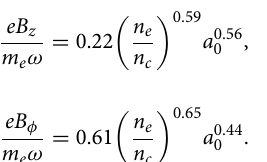
Figure 6. Numerical scaling laws for magnetic field components. Dependence of magnetic field components B z ( a ) and B φ ( b ) on normalized electron density n e / n c and normalized laser amplitude a 0 1 µ wavelength (cid:31) =